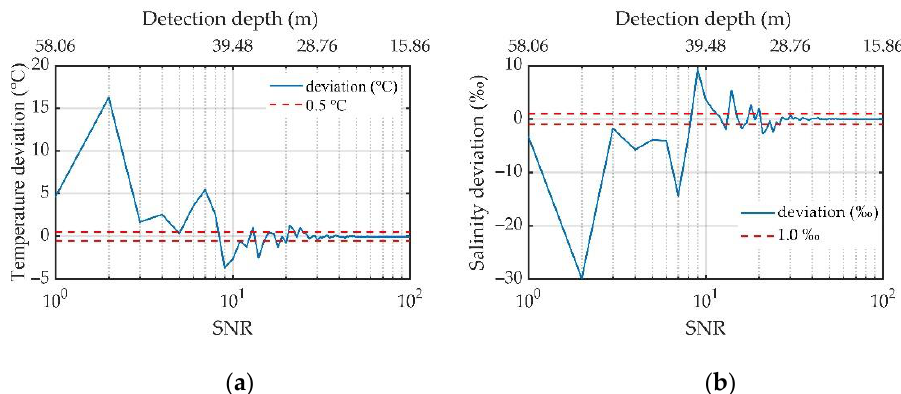
Figure 14. Relationships between the SNR and accuracy of the temperature and salinity measure- ments: ( a ) temperature deviation with respect to the SNR; ( b ) salinity deviation with respect to the SNR.